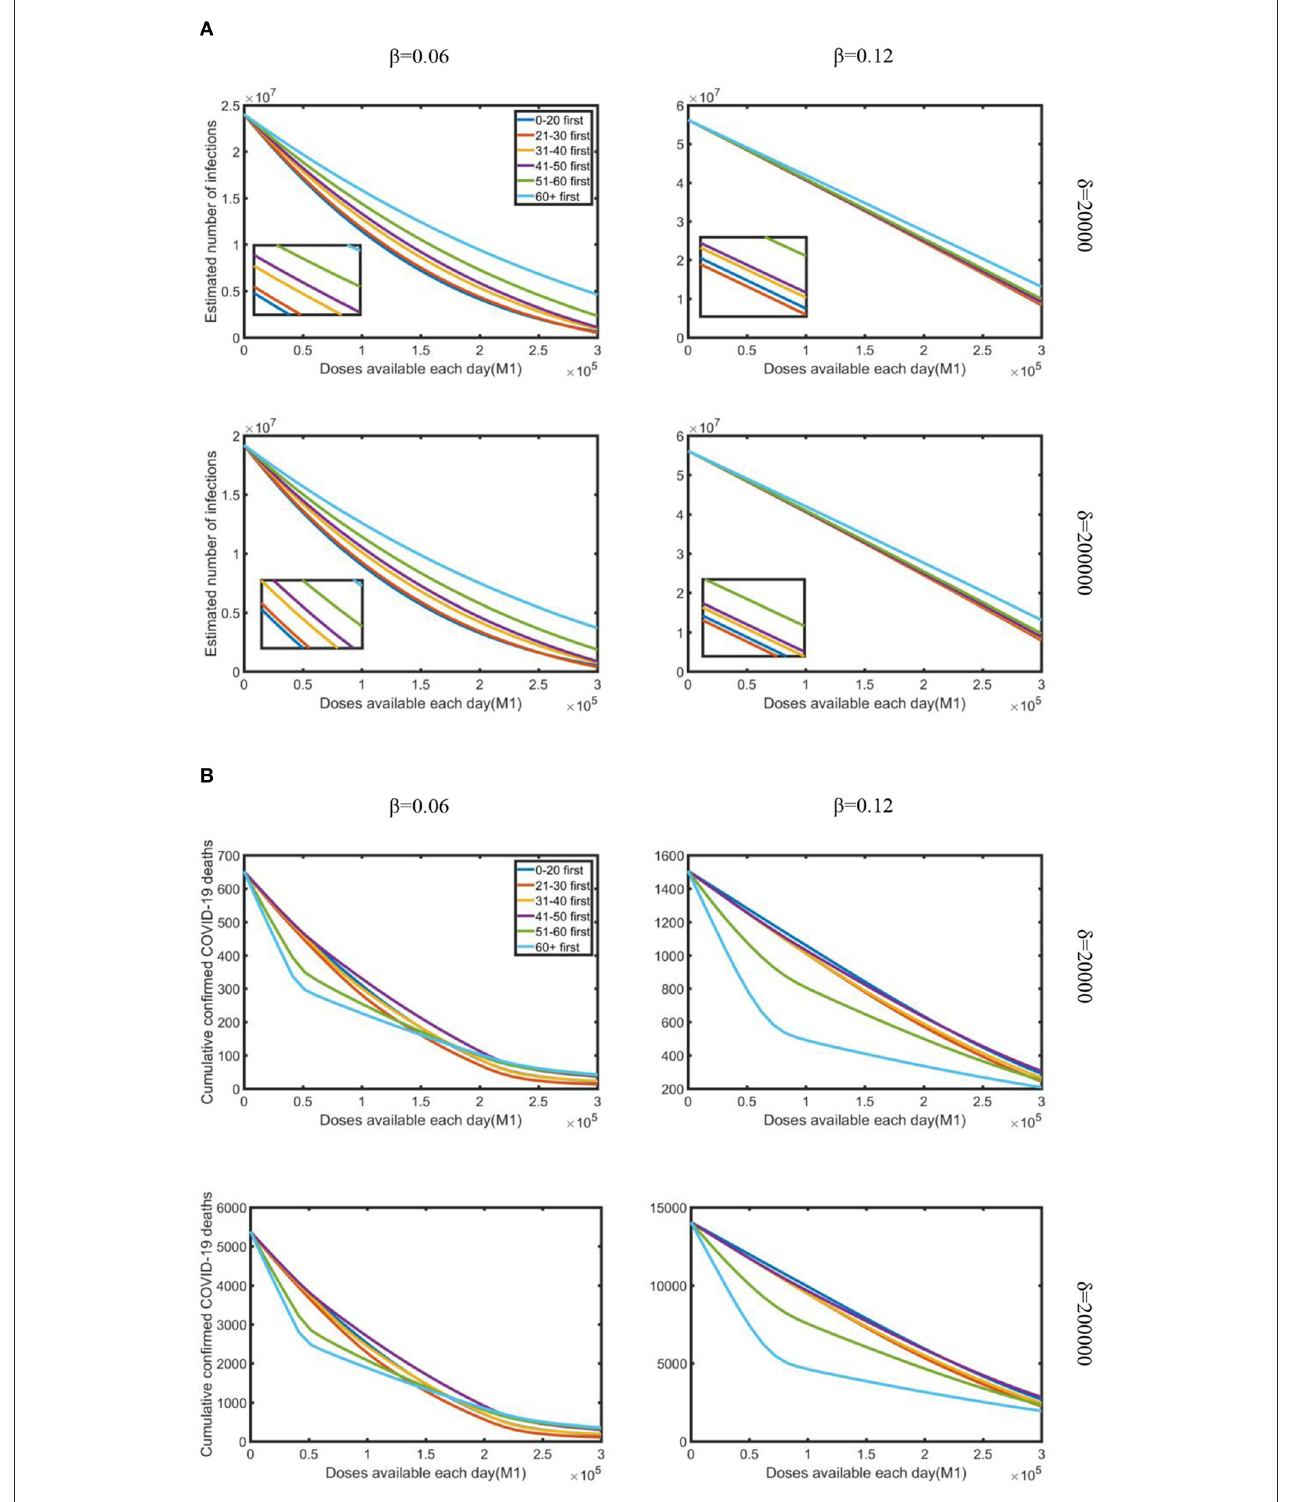
FIGURE 3 | Under strong control measures, the impact of doses available each day on the reduction in the estimated number of infections and cumulative deaths occurred for various daily testing volumes ( δ ) and infection rate ( β ): (A) estimated a number of infections; (B) cumulative confirmed COVID-19 deaths. Testing volume is 20,000 and 200,000, which represent the minimum and maximum testing volume in South Africa during the research period.